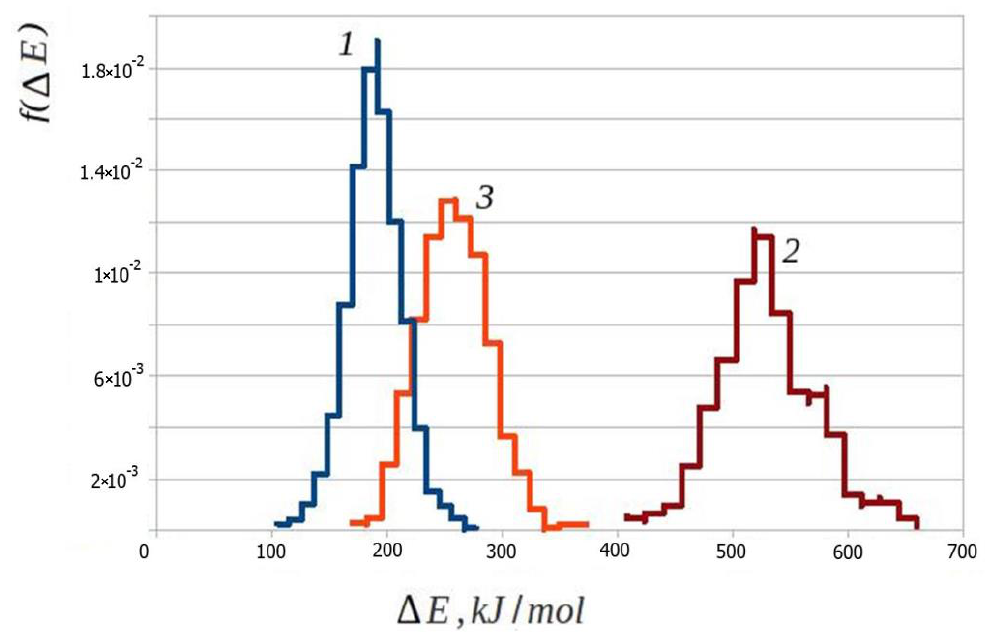
Figure 5. The energy distributions of the AIBN molecule in molecular dynamic modeling: 1 — in the singlet state, 2 — in the triplet state before the time of 250 fs, 3 — in the triplet state after the simulation time of 250 fs. Curve 1 corresponds to the energy distribution of the molecule in the singlet state. Curve 2 corresponds to the distribution of the molecule in the triplet state at simulation time up to 250 fs. Curve 3 corresponds to the distribution of the molecule in the triplet state at simulation time after 250 fs. There are characteristic symmetric distributions for all three curves; however, for a molecule in a triplet state, the dispersion of distributions is slightly higher. It can be seen that curves 2 and 3 correspond to different states. A sharp decrease in energy after 250 fs for the triplet molecule corresponds to a gap in the section of the potential surface in Figure 3 with the exit of the nitrogen molecule from the radical pair. At the same time, as expected, the triplet radical pair is not stable, and the radicals leave into volume. The time required for the relaxation transition from state 2 to state 3 can be characterized as the relaxation time of the oscillatory-excited state — t vib . The question of whether singlet – triplet transitions occur during the decay of the ini- tiator, and accordingly, whether an external magnetic field will affect the probability of decay, is not obvious. Triplet – singlet transitions are observed during the photoinduced decay of initiators [36,37], while an external magnetic field can have a significant effect. That is, the lifetime of triplet radical pairs is sufficient for an inter-combination transition, but a singlet radical pair must recombine quickly. An analysis of the decomposition prod- ucts of azo initiators suggests that such transitions do take place. Particularly in the case of the thermally initiated decomposition, all geminal radical pairs in the absence of inter- combination transitions should be singlets; however, the yield of the recombination prod- ucts of geminal radical pairs seems to be underestimated, given the significant cellular effect [24,38]. On the one hand, the identical structure of the radicals in the AIBN decomposition products, which results in the equality of their g-factors in the main oscillatory state, should lead to the absence of the influence of the magnetic field on the probability of con- version by the Δg mechanism. On the other hand, when the process occurs via the cleav- age of two bonds with the formation of two radicals and a nitrogen molecule, as in the singlet radical pair in Figure 2, the correlation between the formed radicals will be